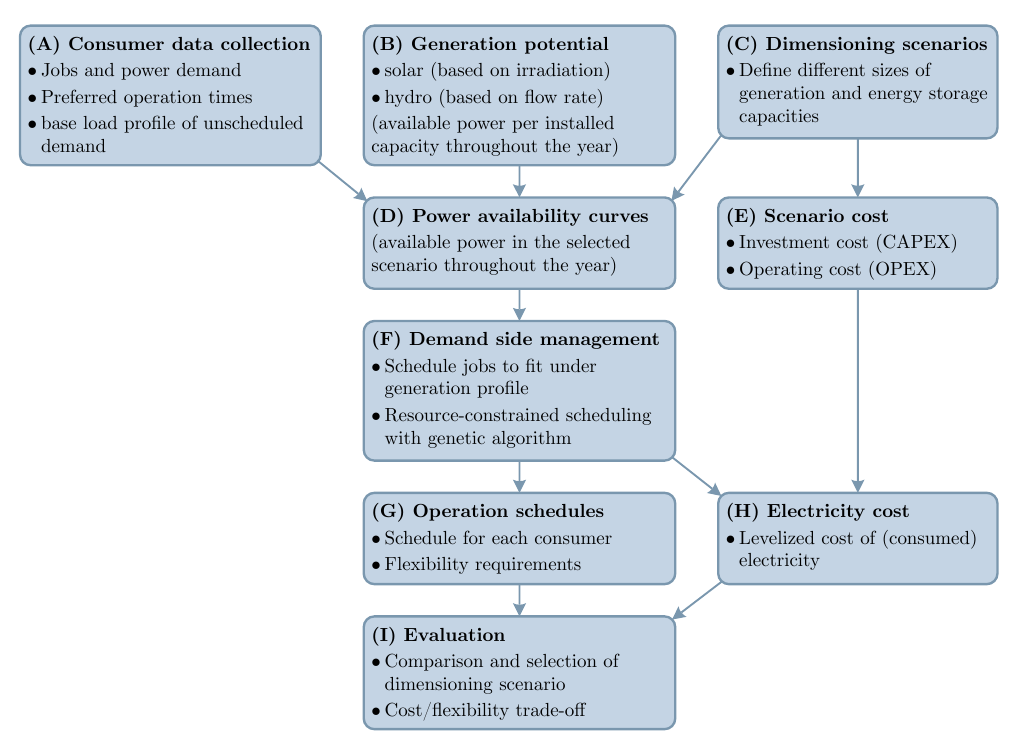
Figure 2. Overview of the proposed microgrid dimensioning approach.